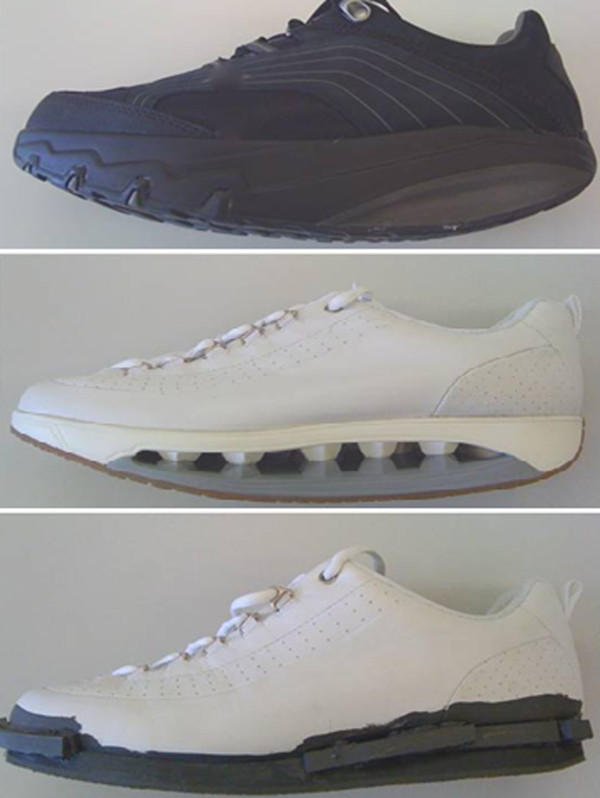
MBT (top) (526 g), rollover shoe rollover footwear (453 g), and weighted flat footwear (453 g) (bottom) (526 g).